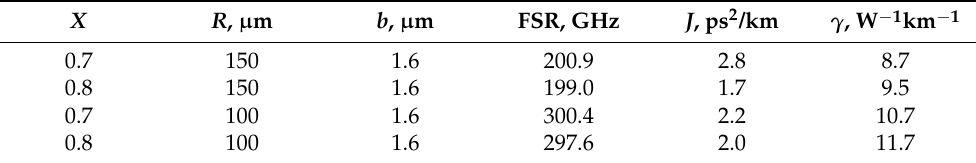
Table 1. Parameters and characteristics of the optimal microresonators for achieving flat, near-zero GVD curves in SCL-band and FSR = 200 GHz or FSR = 300 GHz for λ p ≈ 1.55 μm.